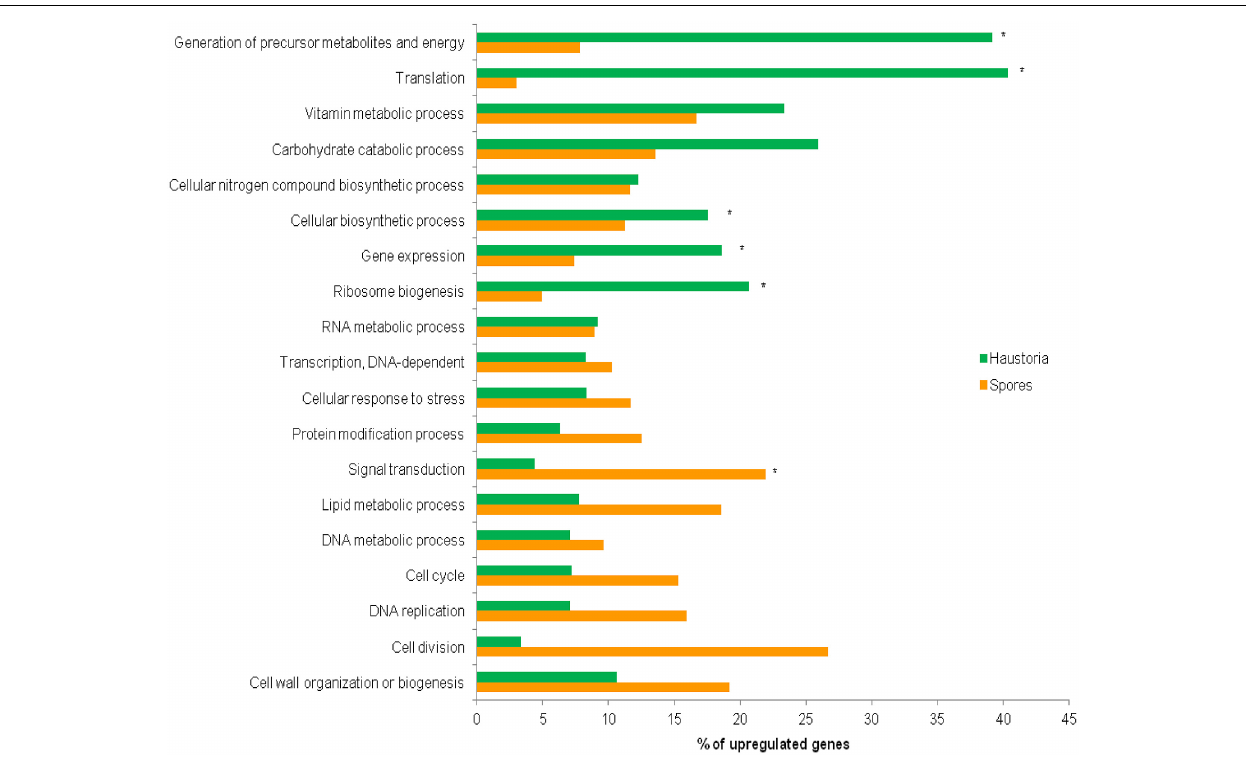
FIGURE 3 | Comparative ontology analysis of genes with statistically significant changes in expression between haustoria and germinated spores. Of the original predicted gene set, 34.6% (794) of the 2,365 haustorial-enriched genes and 46.4% (1,037) of the 2,271 genes up-regulated in germinated spores were annotated with B2G. Relevant